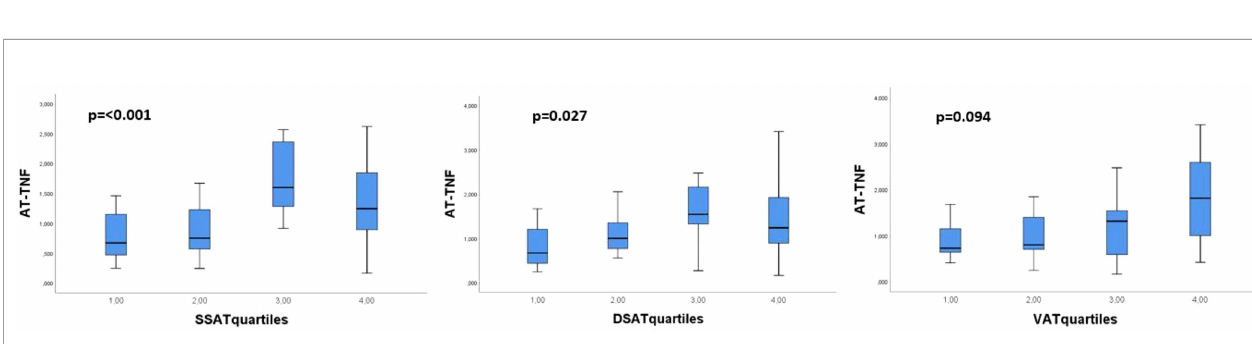
FIGURE 1 | Distribution of circulating adiponectin through quartiles of the abdominal AT compartments sSAT, dSAT and VAT. p-values refer to Kruskal-Wallis test.